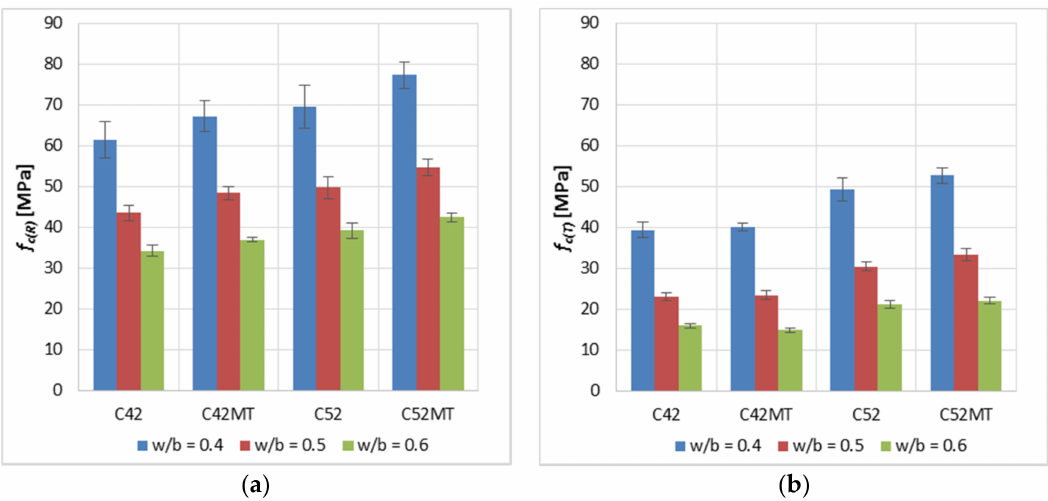
Figure 3. Average compressive strength f c of the modified cement pastes (error bars mean standard deviations): ( a ) reference samples; ( b ) samples after thermal